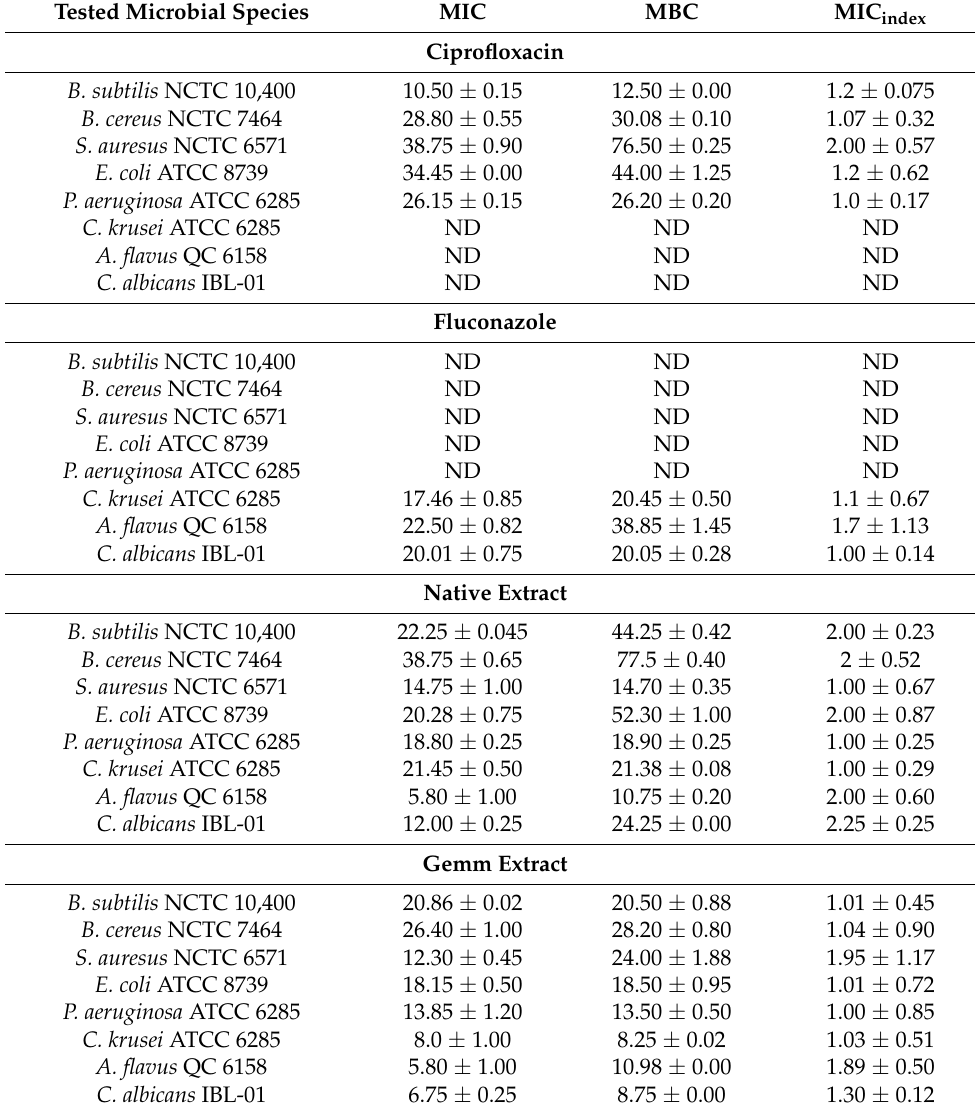
Table 5. Antimicrobial activity of native and gemm extracts of H . griffithi . Tested Microbial